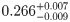
MSD of TonB and of FepA.a) MSD of TonB (solid circles) and of FepA (solid squares). b) Fit to confined diffusion model for TonB (data: solid circles, fit: open circles) which gives best fit parameters of a confinement radius of 0.266−0.009+0.007 μm with short-time (microsecond timescale) diffusion coefficient in the range 5.4−0.8+1.5 μm2/s. c) Fit to confined diffusion model for FepA (data: solid squares, fit: open squares) which gives best fit parameters of a confinement radius of 0.180−0.007+0.006 μm with short-time (microsecond timescale) diffusion coefficient in of 21−5+9 μm2/s.